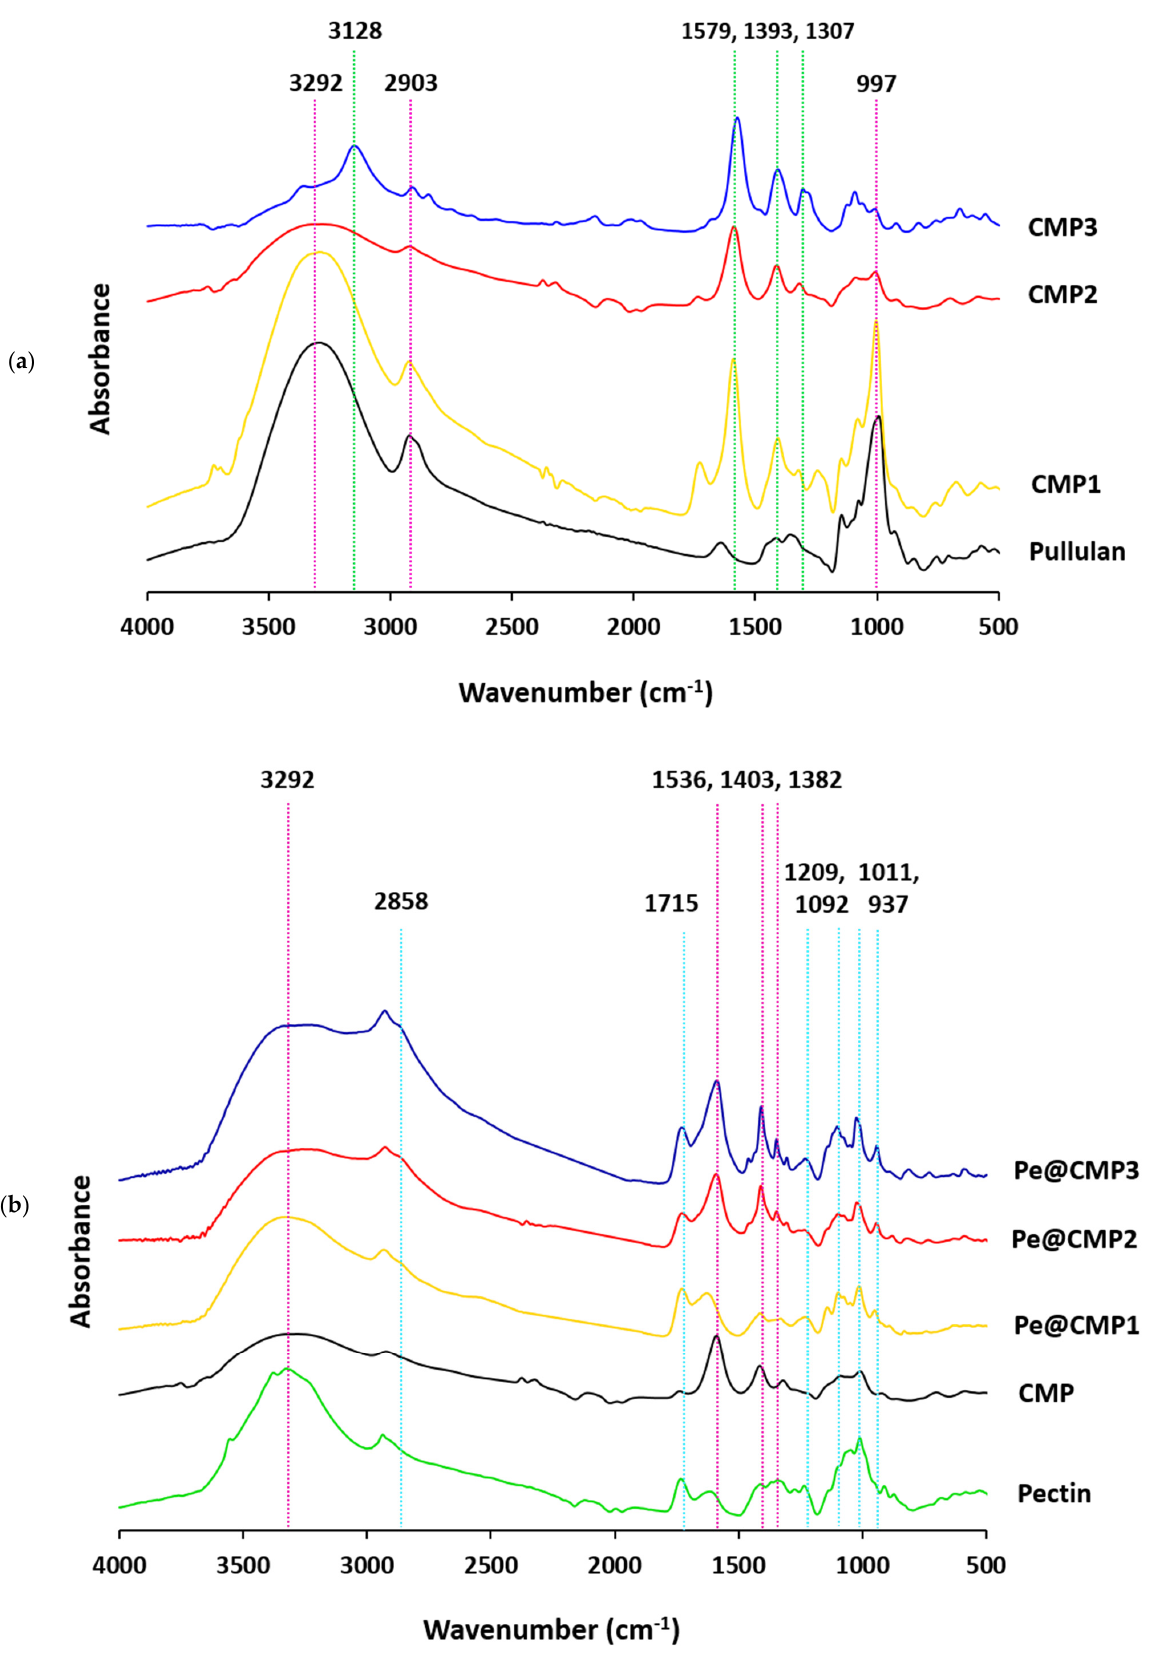
Figure 2. FTIR spectra for the prepared; ( a ) CMP and ( b )